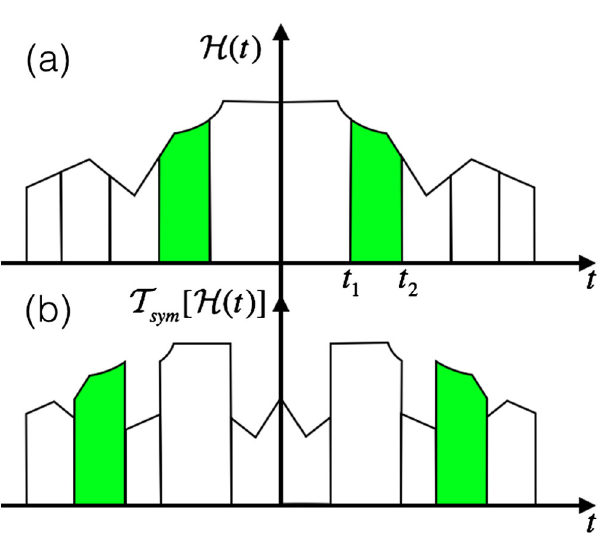
FIG. 11. The Hamiltonians in (a) and (b) are related by symmetric rearrangement of the time segments. Up to a small correction O ð s 3 Þ , the change in expectation values of an observable A that takes place during the green segments is the same in both cases. This effect explains why work and heat are the same in various types of engines when s is small compared to ℏ (equivalence